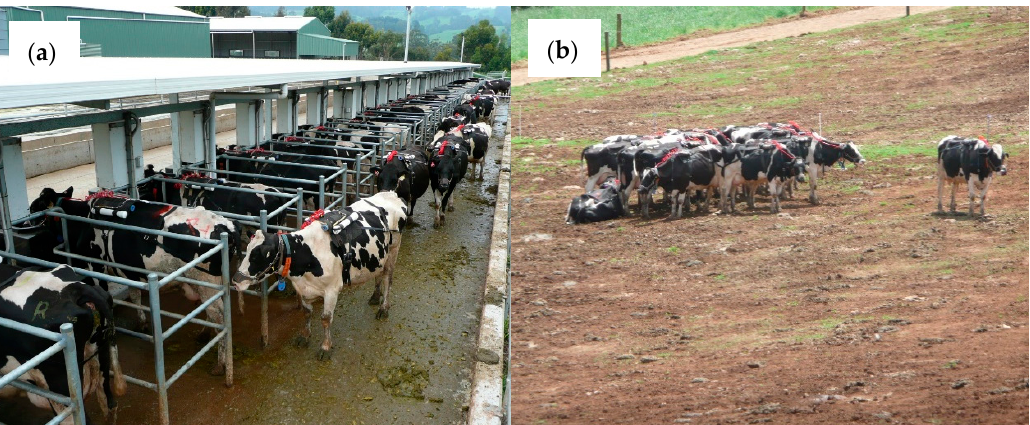
Figure 1. Cows fitted with equipment for methane measurements by the SF 6 technique and eating outdoors at the auto-recording feed bins ( a ) and cows loafing on a bare paddock ( b ).